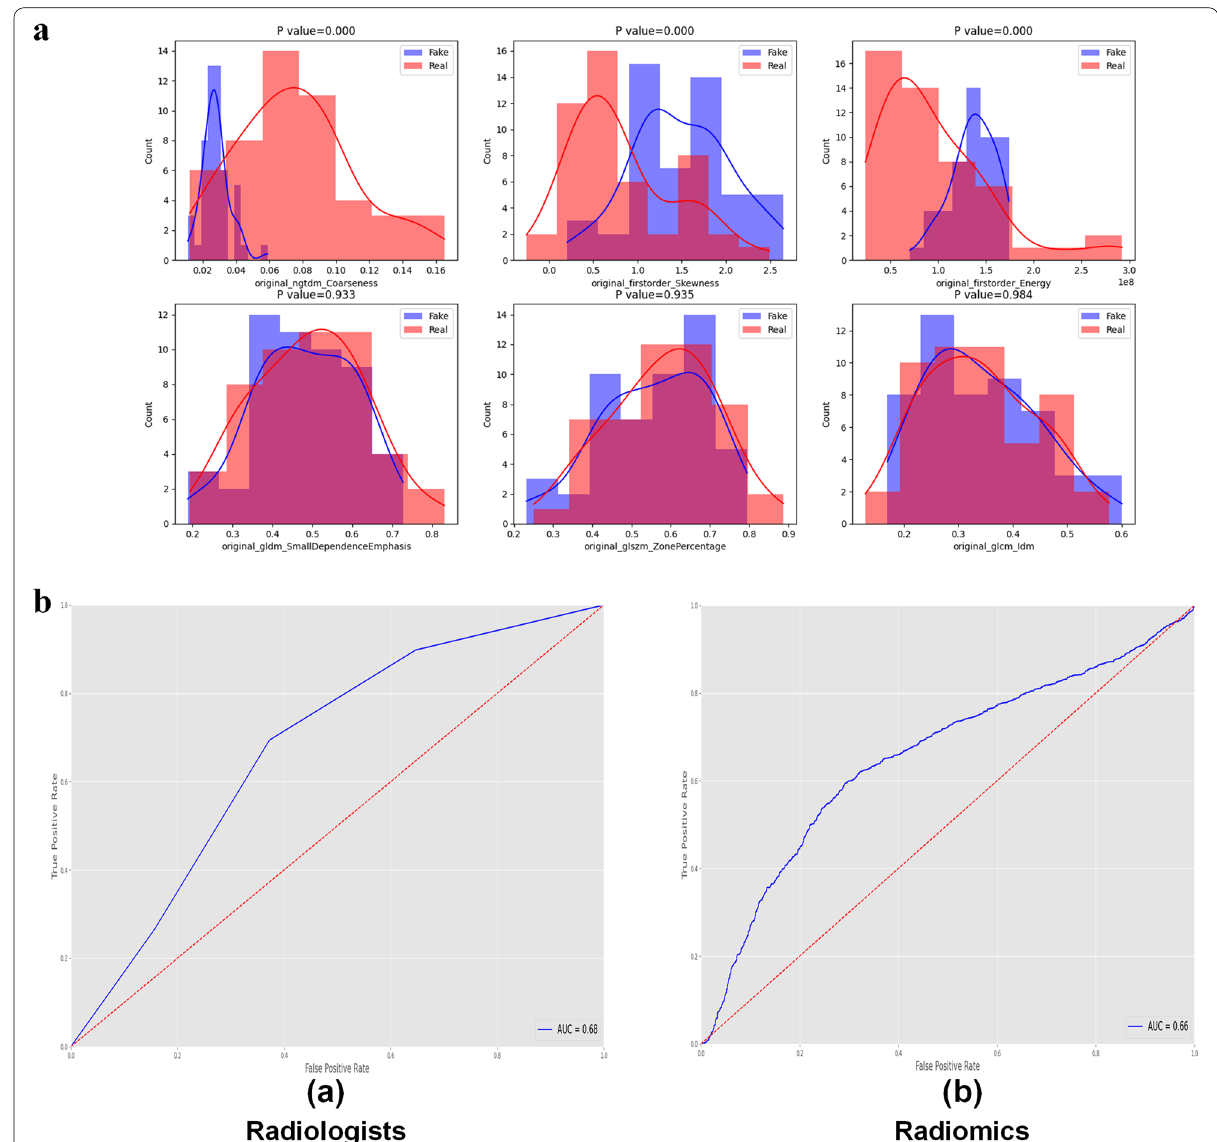
Fig. 5 a Examples for the comparison of radiomics features distribution between real and fake ground glass nodules (GGNs). The comparison of radiomics features distribution extracted from synthetic and real images with minimum three p -values shows in the upper row. The comparison of radiomics features distribution extracted from synthetic and real images with maximum three p -values shows in the lower row. b , c Receiver operating characteristic curve of the prediction of distinguishing real and fake GGNs. by radiologists ( a ) and by the logistic regression model ( b